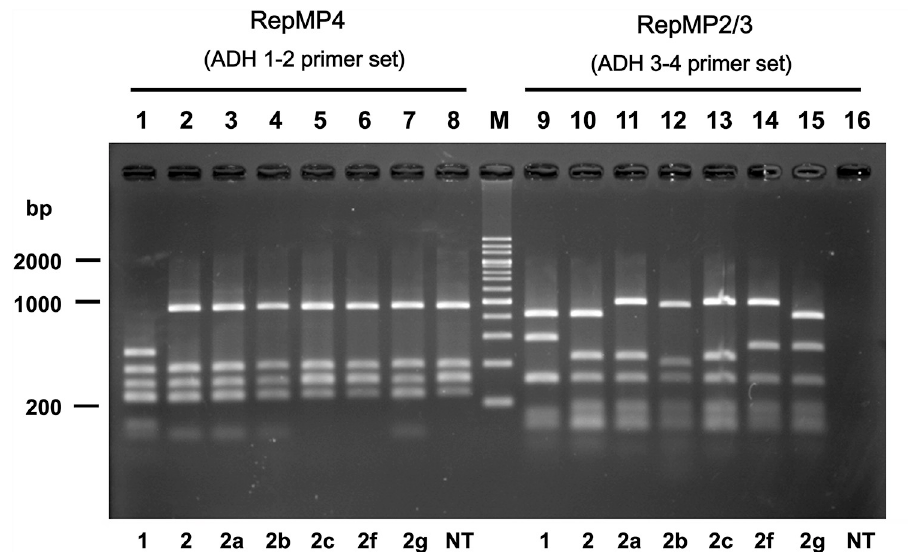
Fig 2. PCR-RFLP typing of the p1 gene. M . pneumoniae isolates from 419 patients in this study were classified into eight p1 gene types by PCR-RFLP analysis. The RFLP patterns of the RepMP4 region (lanes 1 to 8) and the RepMP2/3 region (lanes 9 to 16) that represent eight p1 gene types are shown. p1 gene types corresponding to RFLP patterns are indicated below the gel image. NT indicates non-typable strain M241 (see text). Lane M contains size markers (200 bp ladder). Type 2b is also referred as type 2V in other reports [26,49].The original electrophoresis image is shown in S3